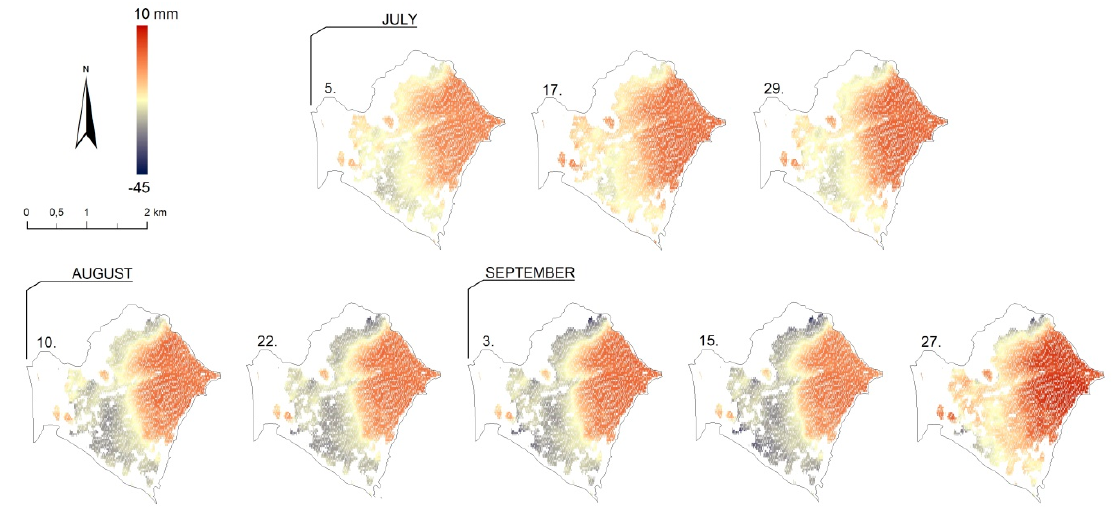
Figure 10. Vertical displacements of terrain surface indicated in Line of Sight Small Baseline Subset (LOS SBAS) analysis.